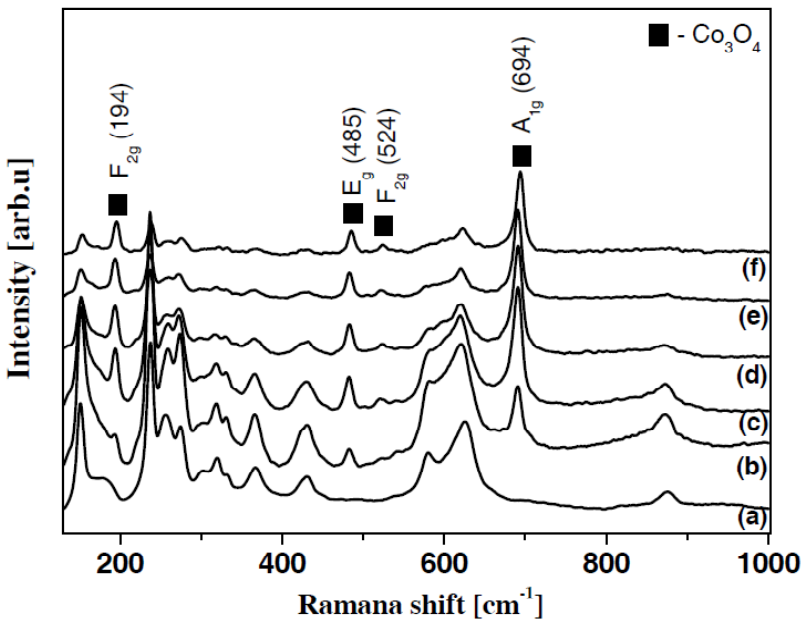
Figure 3. Raman spectra of samples: LiNbO